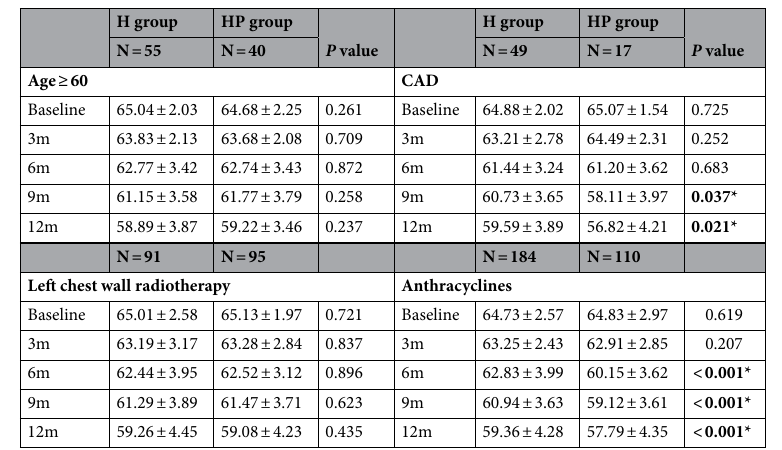
Table 4. LVEF of patients in H group and HP group under various risk factors. Significant values are in [bold]. m month. * P < 0.05.